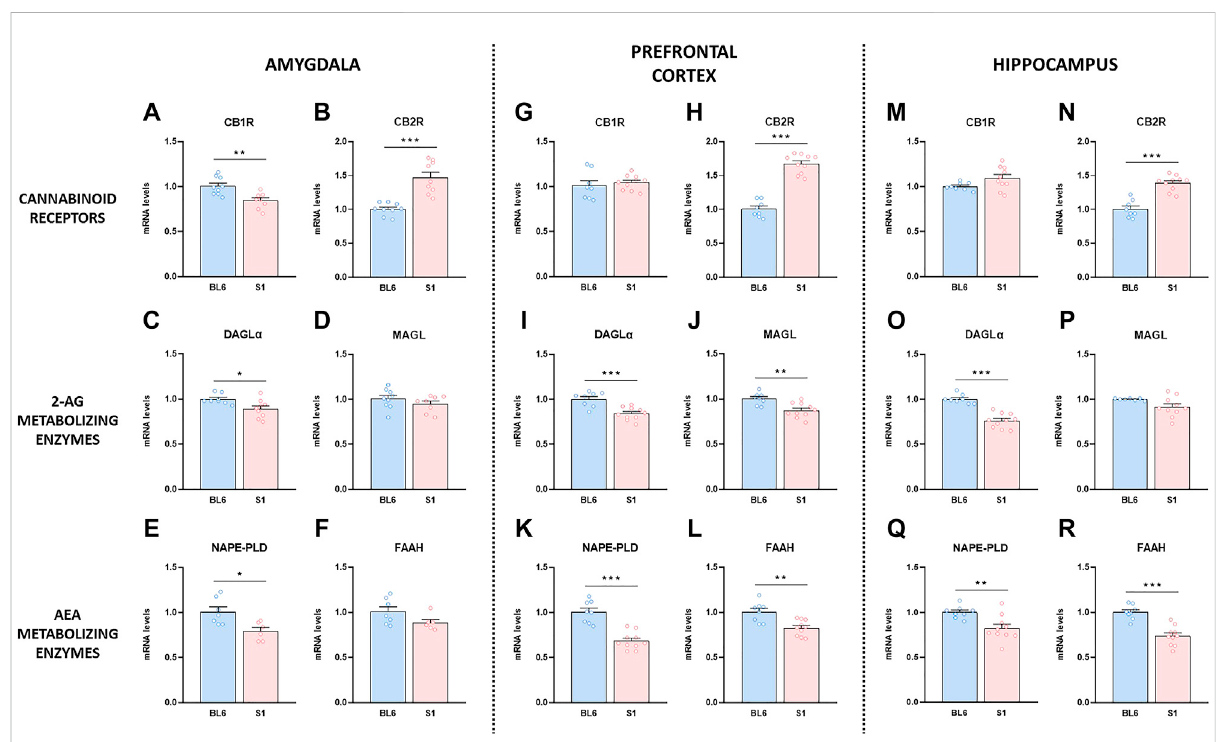
Changes in gene expression of the endocannabinoid system compounds in the S1 strain compared with BL6. Gene expression levels of the CB1R and CB2R, the 2-AG metabolizing enzymes DAGL α and MAGL, and the AEA metabolizing enzymes NAPE-PLD and FAAH in amygdala (A – F) , prefrontal cortex (G – L) and hippocampus (M – R) in BL6 and S1 mice ( n = 6 – 10 mice per group). Data are expressed as mean ± SEM. * p < 0.05, ** p < 0.01, *** p < 0.001 (comparison between BL6 and S1). BL6: C57BL/6J mice strain; S1: 129S1/SvImJ mice